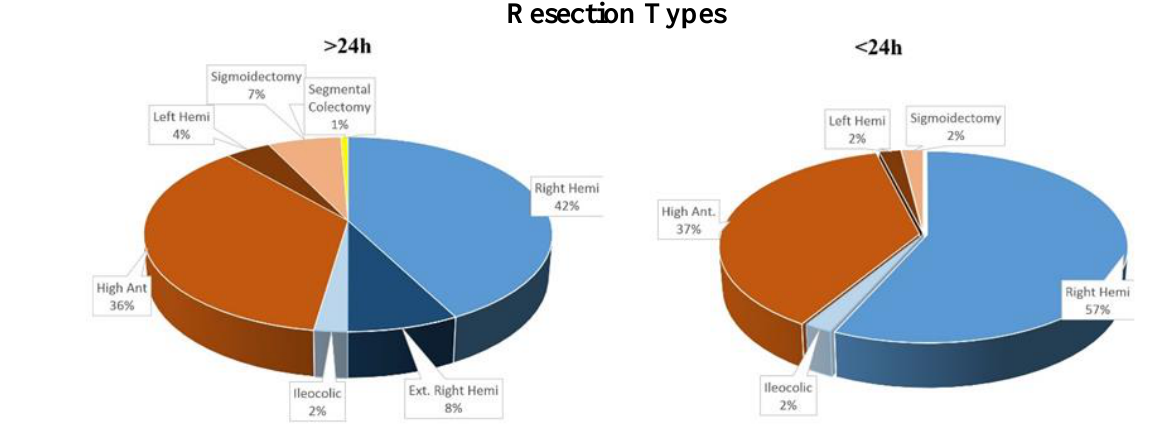
Figure 2. Types of resections performed.